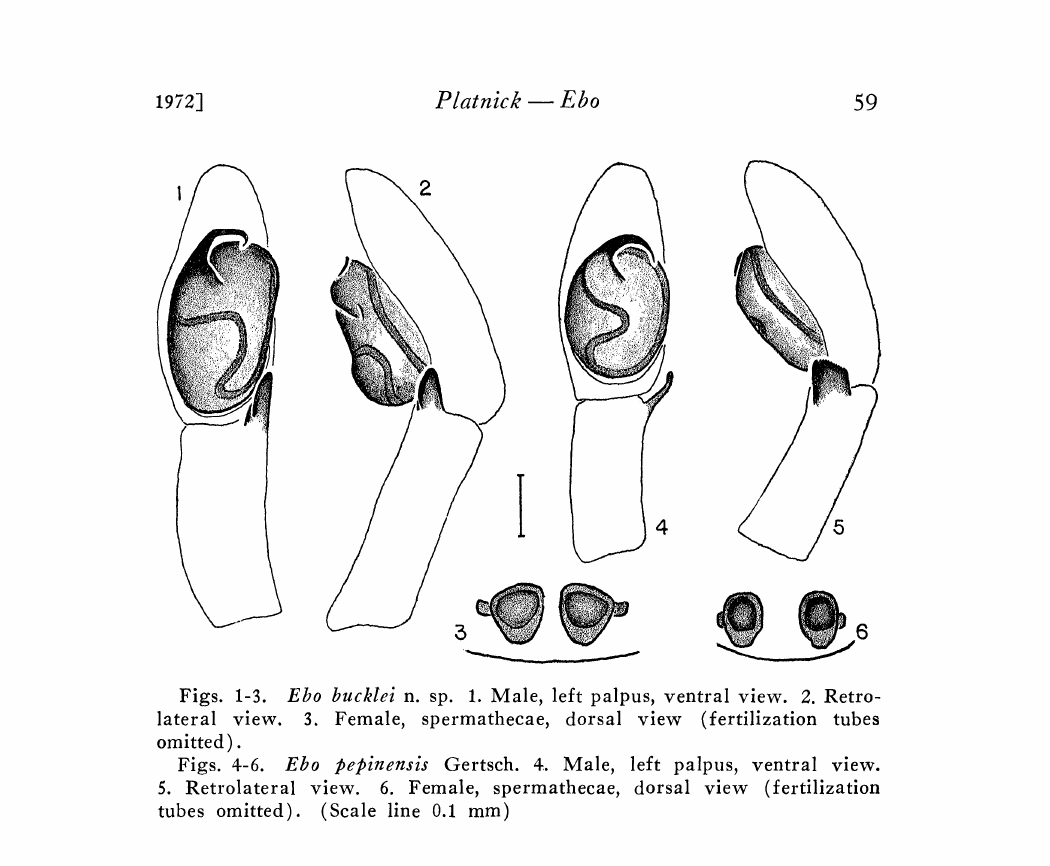
Figs. 1-3. Ebo bucktei n. sp. 1. Male, left palpus, ventral view. 2. Retro- lateral view. 3. Female, spermatheeae, dorsal view (fertilization